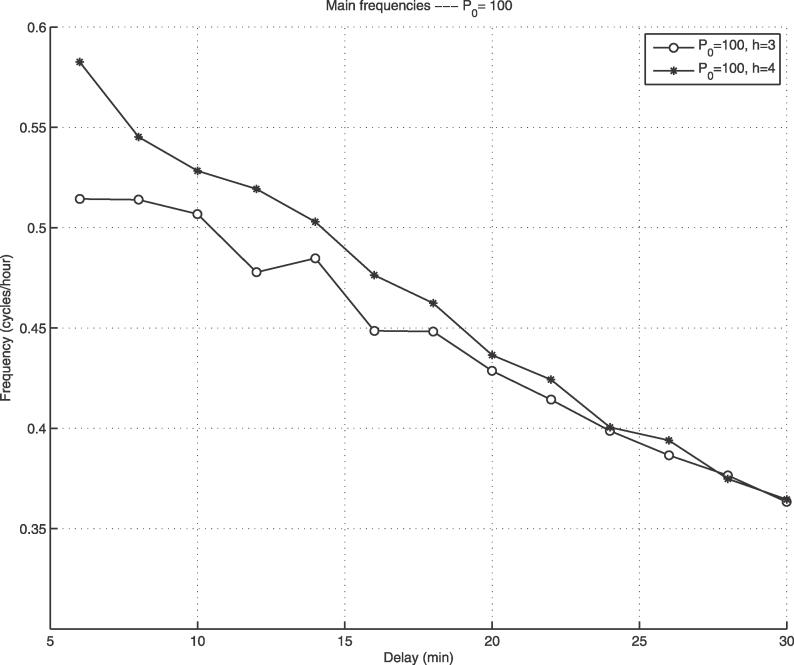
Mean Oscillation Frequencies for Different Delay Values (P
0, h, μm, μp Are Fixed)